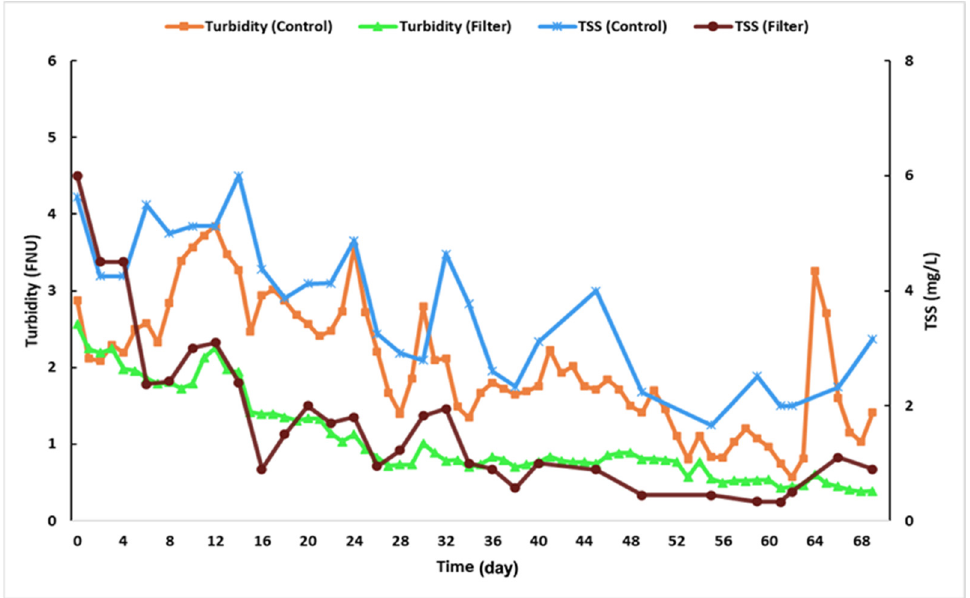
Figure 10. Turbidity (FNU) and total suspended solids concentrations (mg/L) for the 2019 summer in situ experiment.